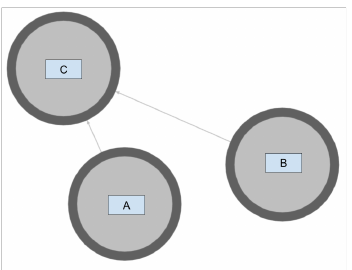
Figure 5. Illustration of a Twitter interaction where nodes indicate Twitter users and links indicate a tweet from a user, tagging another user.